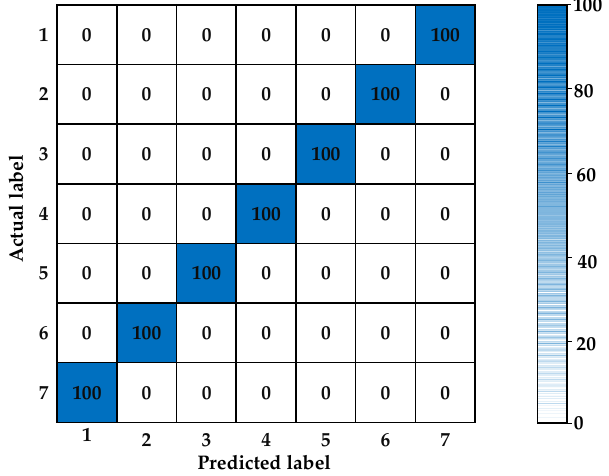
Figure 10. Classification confusion matrix of CEEMDANICA-TDCNN.